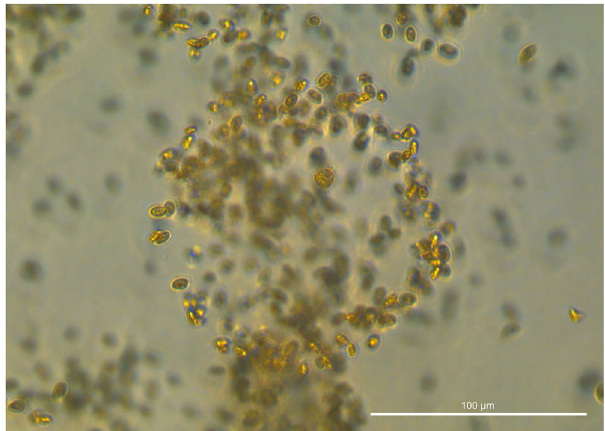
Fig. 1 Mixotrophic feeding impacts the carbon cycle. The mixotrophic protist Prorocentrum cf. balticum (center) observed within the circular perimeter of its mucosphere, which is laden with captured Cryptophyte ( Rhodomonas salina ) prey cells. Abandoned mucospheres sink, contributing to ocean carbon sequestration.Credit: Dr. Michaela E.